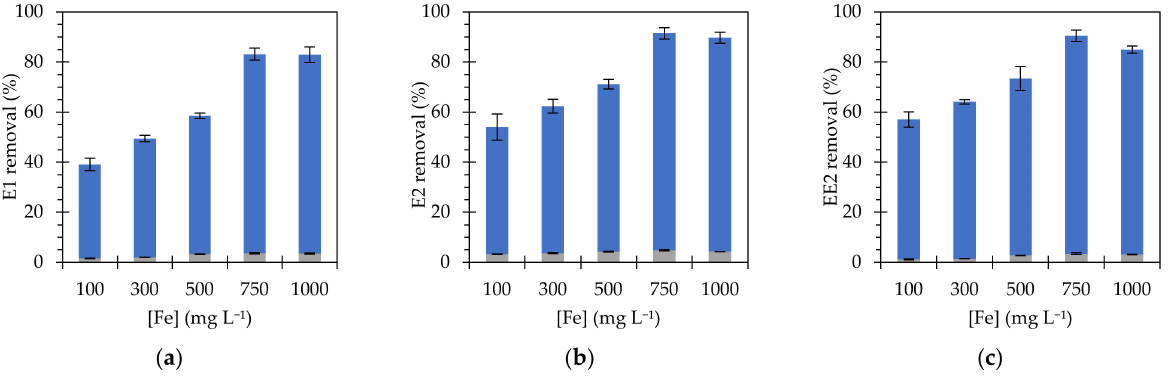
Figure 4. Effect of Fe concentration on the removal of ( a ) E1, ( b ) E2 and ( c ) EE2 (initial concentration of 350 µ g L − 1 ), using Fe 3 O 4 @PAA/SBA15, after 6 h. Blue bars represent estrogen removal by Fenton reactions; grey bars represent estrogen removal by